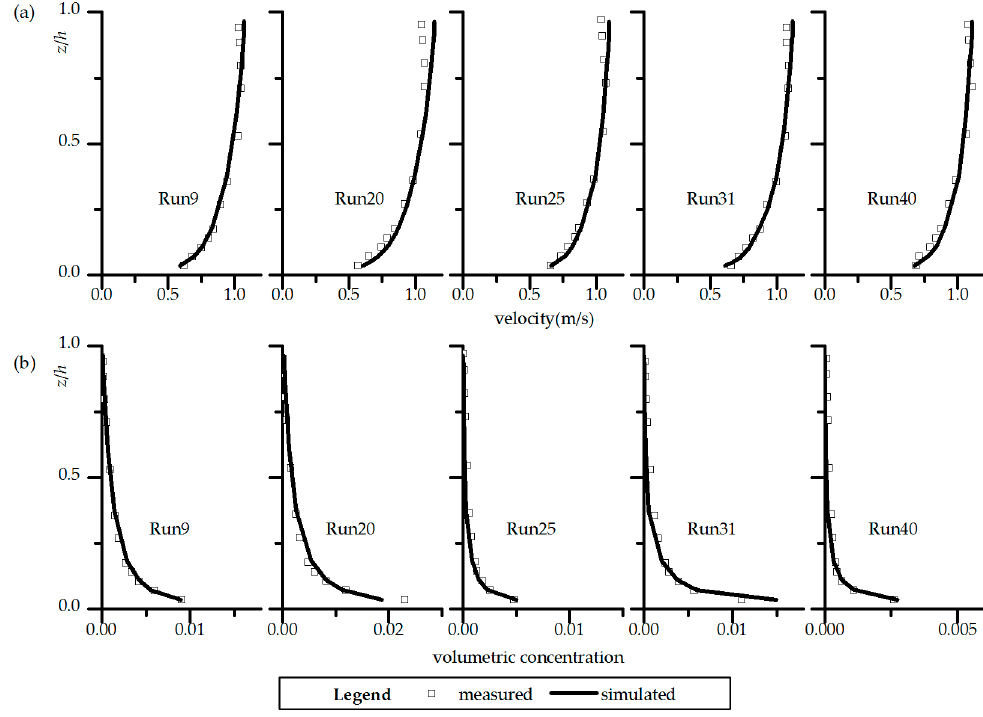
Figure 1. Equilibrium condition: estimated profiles of velocity ( a ) and sediment concentration ( b ) in comparison with the experimental data.